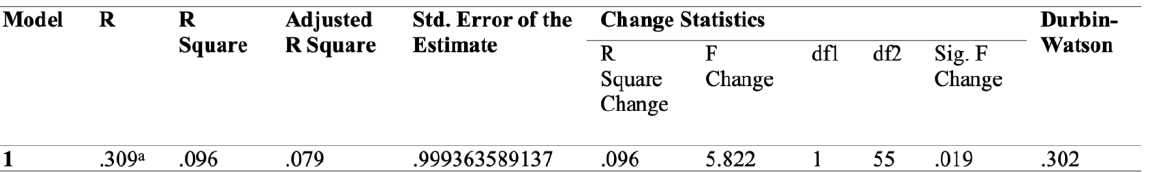
Table 5: Hypothesis 1 Testing Result Model Summary